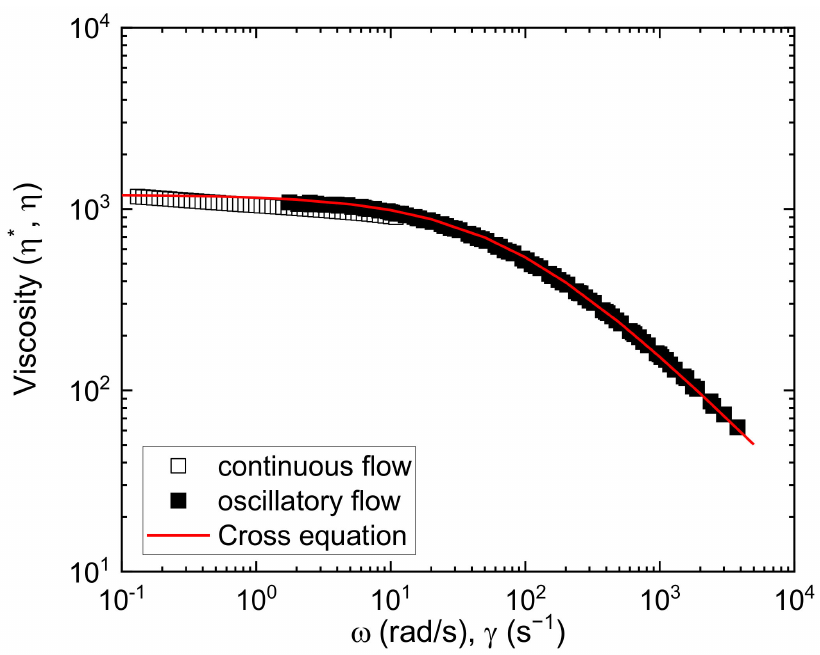
Figure 5. PHBH viscosity curves at T = 190 ◦ C from continuous flow and oscillatory flow (TTS superposition master curve). A fitting to the Cross equation is included [ η 0 = 1200 Pa s, λ 0 = 0.013 s, and α =